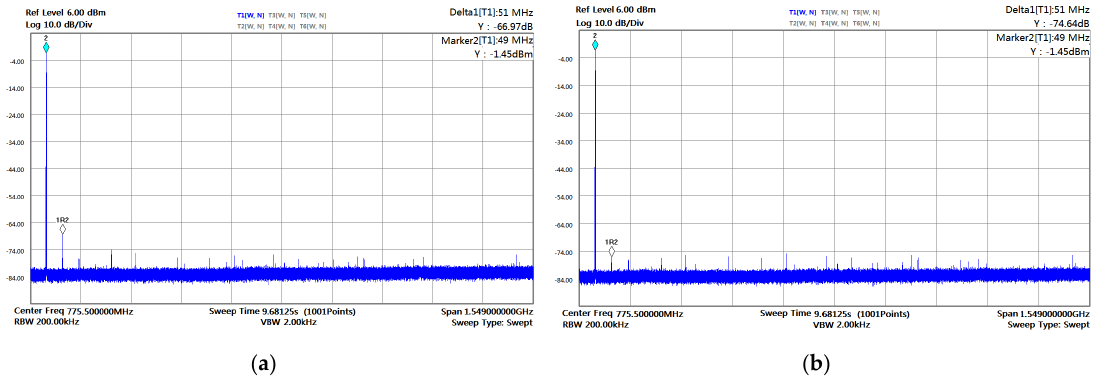
Figure 8. Measured static performance ( a ) di ff erential nonlinearity (DNL); ( b ) integral nonlinearity (INL).